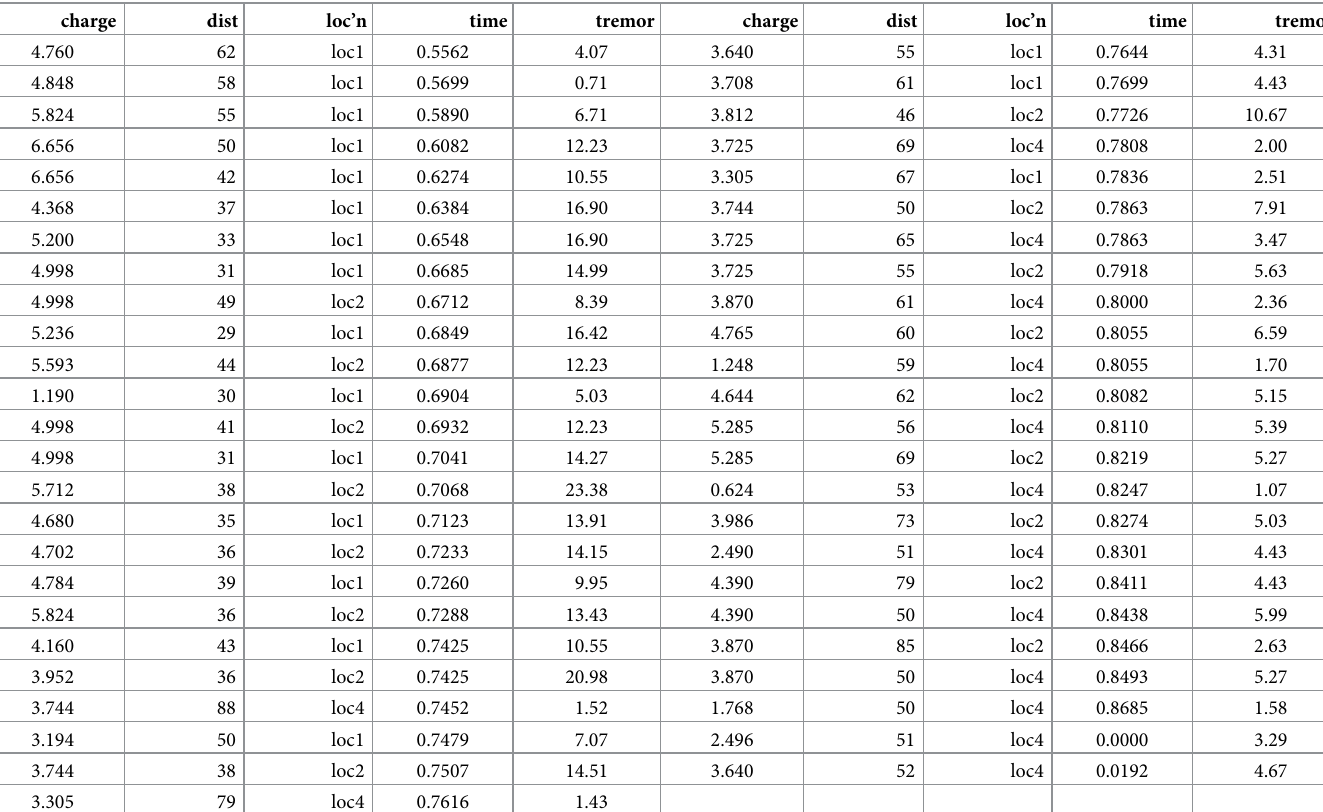
Table 6. Data for the blasting example.